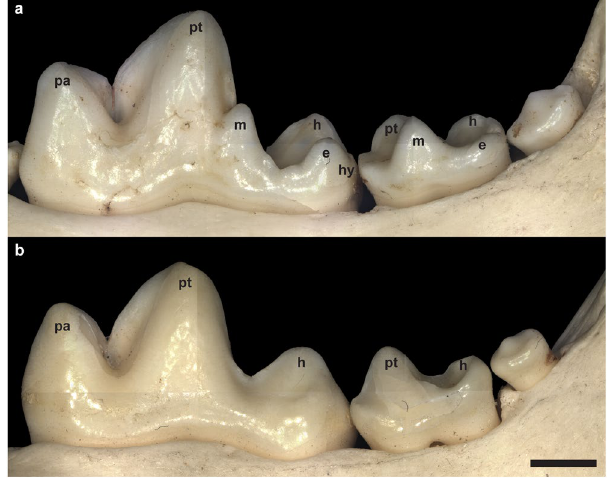
Figure 2. Mandibular right first, second and third molars in lingual view of ( a ) coated (MAM1491) and ( b ) hairless dog (MAM1497). Note the clearly developed metaconid (m), entoconid (e) and hypoconulid cusps (hy) in the coated dog which are lacking in the hairless dog. h = hypoconid, pa = paraconid, pt = protoconid. Teeth are shown in lingual view. Mesial is to the left. The black scale bar equals 3 mm.